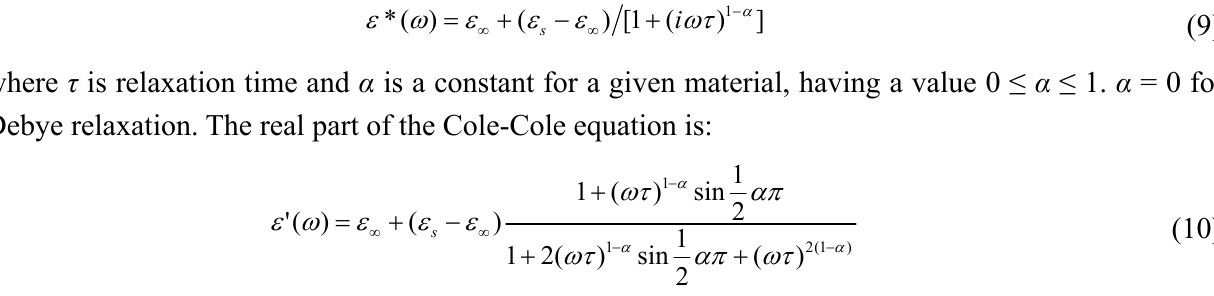
Table 1. All of the data perfectly fitted, but the relaxation time was too small (e.g., 10 − 11 s), as shown in Table